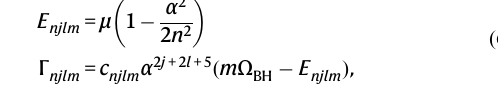
Fig. 2 | Maximal Hills mass including superradiant spin-down for scalars and vectors. Blue:regionintheplaneoftheULBmass μ andSMBHmass M BH ,wherethe BH mass exceeds the maximal Hills mass for a Sun-like star allowed by thin-disk spin-up and superradiant spin-down from scalars ( a ) or vectors ( b ). Gray: region